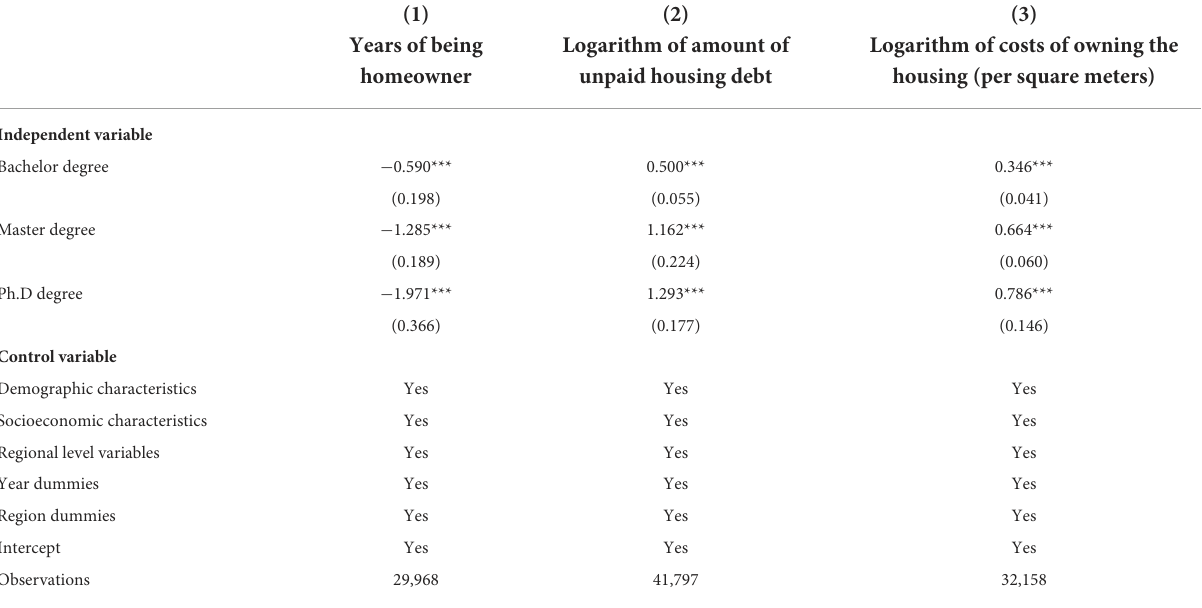
TABLE 16 Relationship between different educational degrees and housing